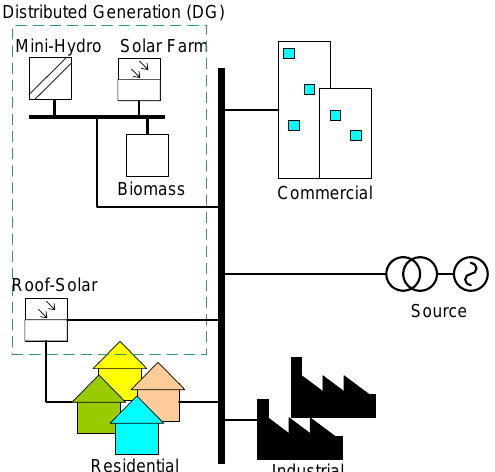
Figure 1. A representation of distribution grid- interconnected with renewable sources and distribution loads [21].